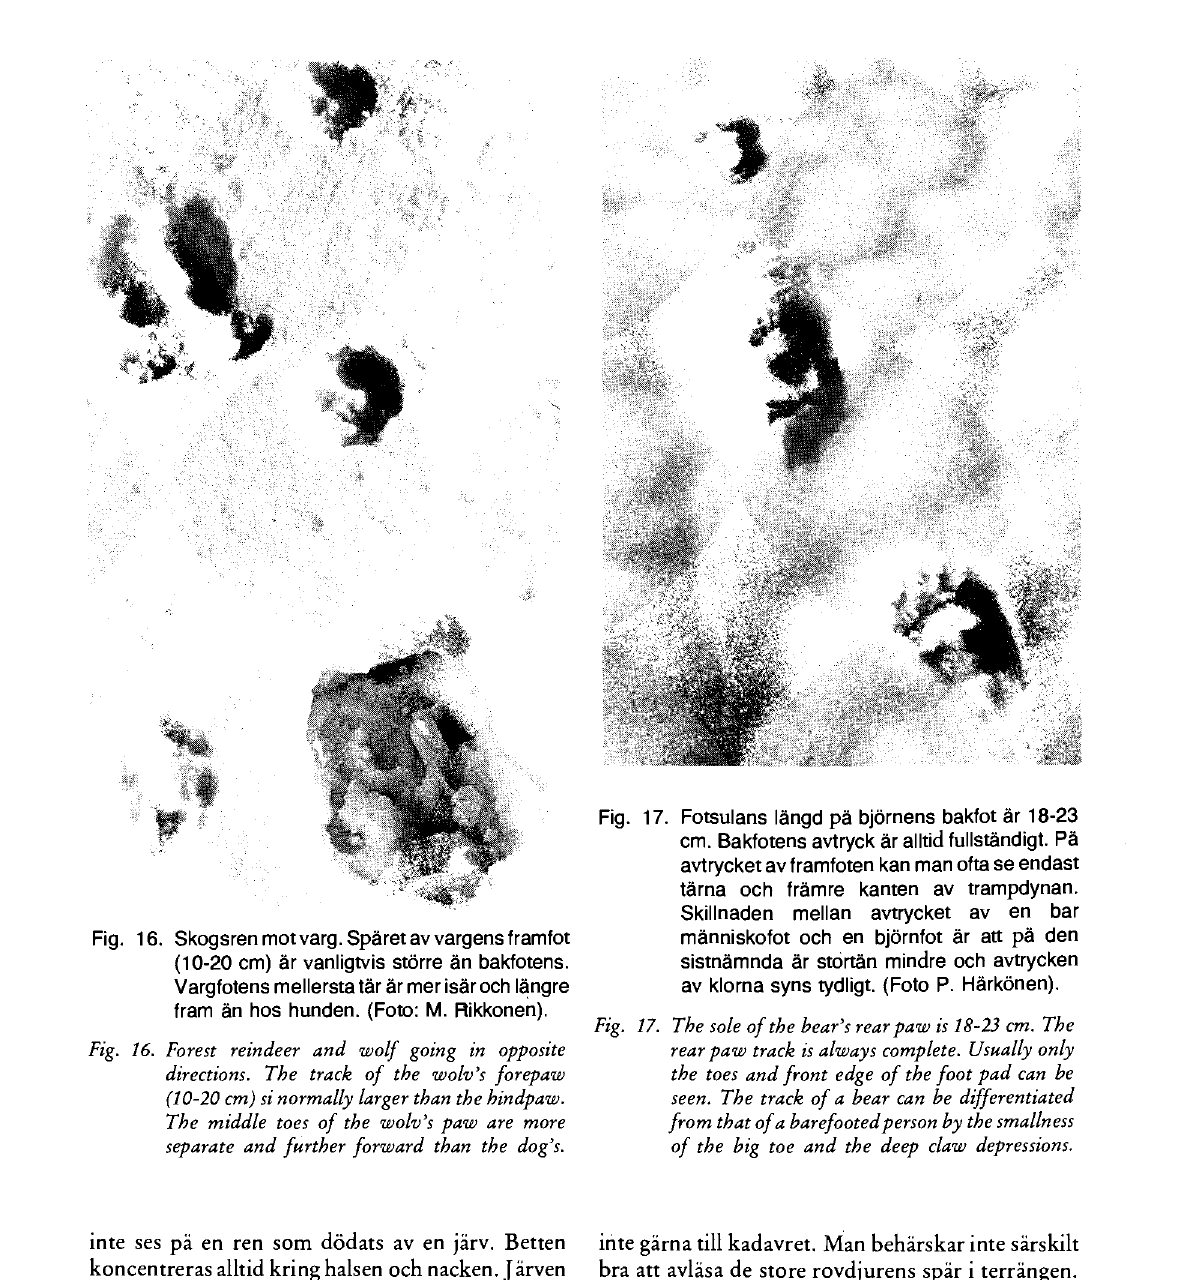
Fig. 16. Skogsren mot varg. Spåret av vargens framfot (10-20 cm) år vanligtvis storre ån bakfotens. Vargfotens mellersta tår år mer isår och långre fram ån hos hunden. (Foto: M. Ftikkonen). Fig. 17. The sole of the bear's rear paw is 18-23 cm. The Fig. 16. Forest reindeer and wolf going in opposite rear paw track is always complete. Usually only the toes and front edge of the foot pad can be directions. The track of the wolv's forepaw seen. The track of a bear can be differentiated (10-20 cm) si normally larger than the hindpaw. from that of a barefooted person by the smallness The middle toes of the wolv's paw are more of the big toe and the deep claw separate and further forward than the dog's.